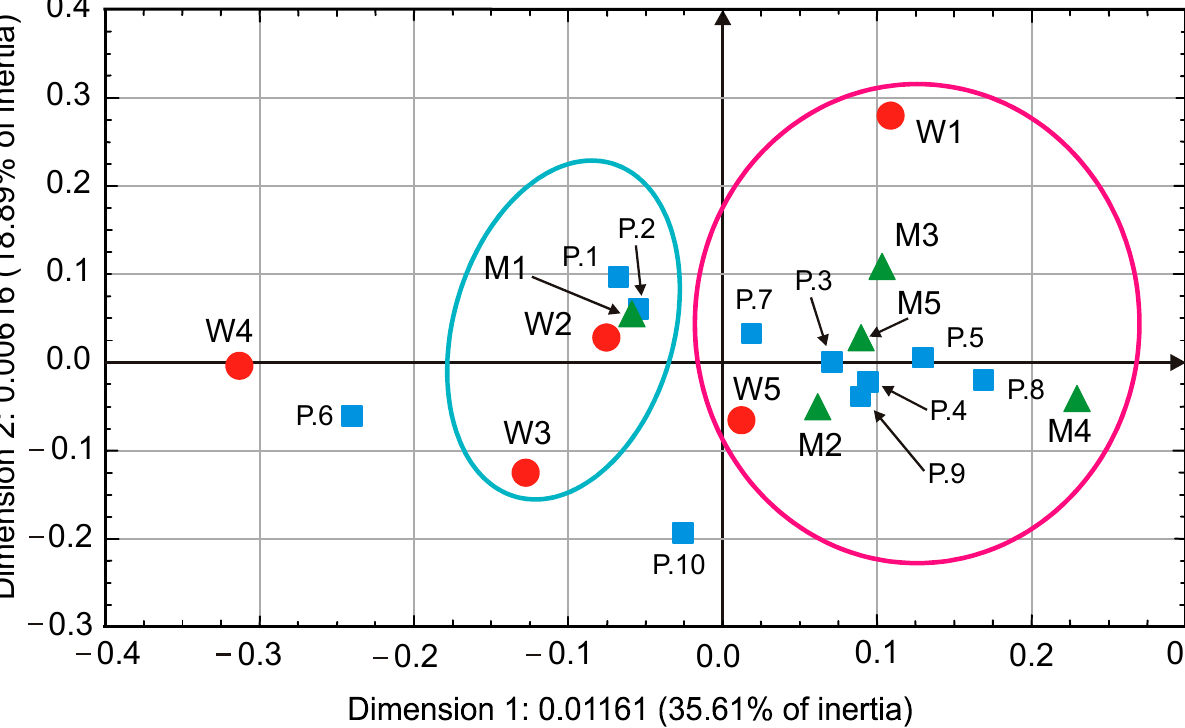
Figure 4. Two dimensional plot of column and row coordinates: dimension 1 × 2. Input table (rows × columns): 10 × 10.